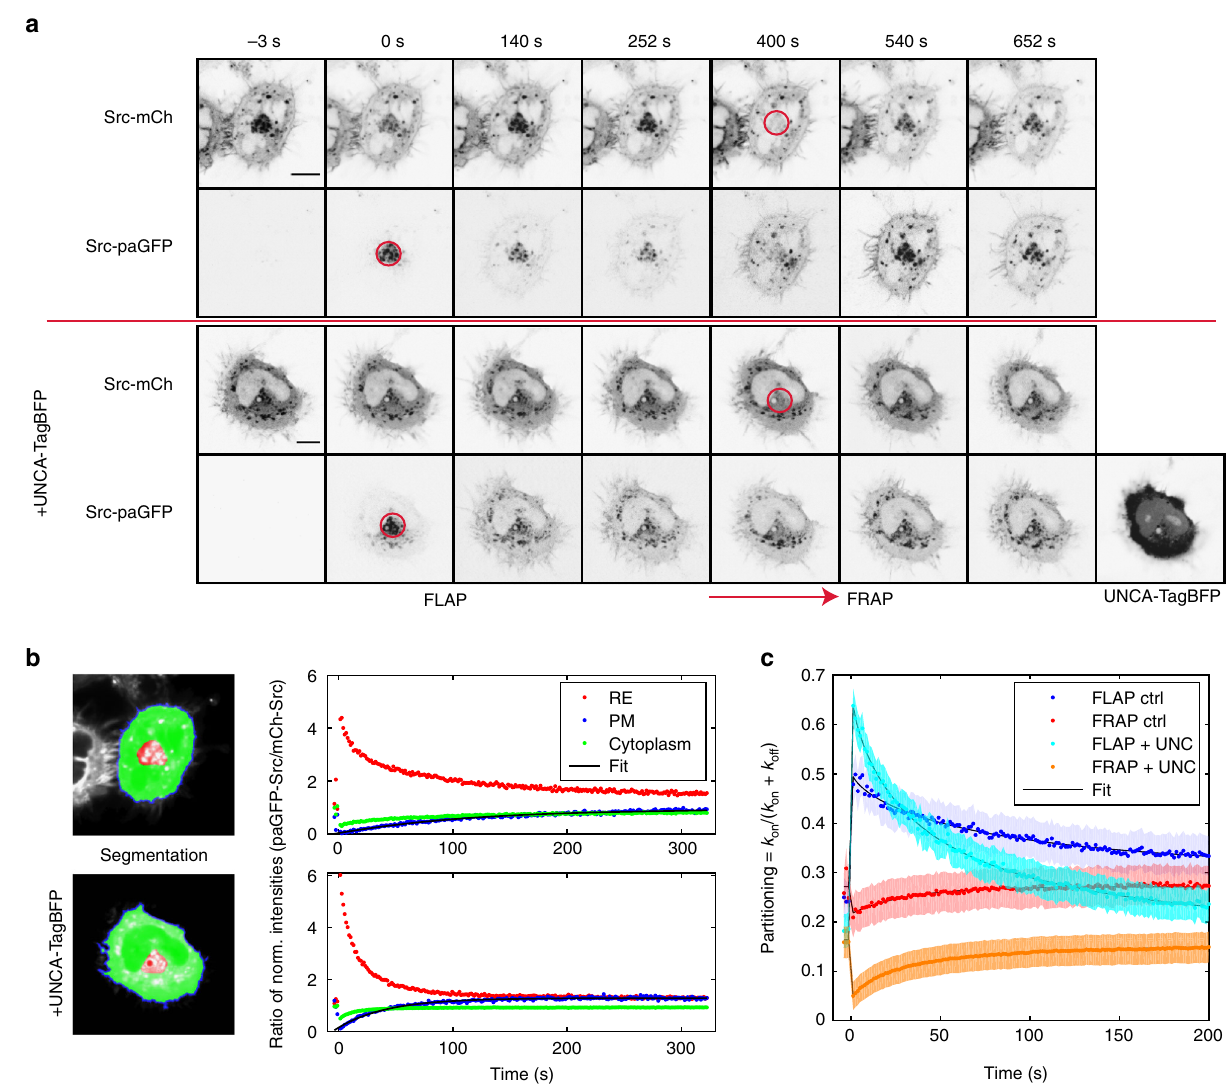
Fig. 6 Src released from UNC119 by Arl2/3 is trapped at the RE to be transported to the PM. a Representative time-lapse sequences of fl uorescence distribution of HeLa cells co-expressing Src-mCh ( fi rst and third rows ) and SrcWT-paGFP ( second and fourth rows ) in the absence ( fi rst and second rows ) or presence ( third and fourth rows ) of UNC119A-TagBFP ectopic expression. Src-paGFP was photoactivated at 0 s in the perinuclear region and subsequently Src-mCh was photobleached at 400 s in the same area (photoactivation/photobleach area: red outline ). b Segmentation of cells in ( a ): RE ( red ), PM ( blue outline ) and communicating cytoplasm ( green ). The ratio of Src-paGFP fl uorescence per segment (RE, red ; PM, blue ; cytoplasm, green ) over total fl uorescence in the cell and normalised to the respective ratio of Src-mCh fl uorescence was plotted against time. The PM ratio was fi tted to a mono-exponential recovery ( black line ). c Average traces of FLAP and FRAP curves fi tted to the compartmental model described in Methods. Loss of Src-paGFP fl uorescence at the perinuclear region normalised to whole-cell Src-paGFP fl uorescence ( blue and cyan curves ) and corresponding gain of Src-mCh fl uorescence after photobleaching at the same ROI, normalised to whole-cell Src-mCh fl uorescence ( red and orange curves ). Control cells: mean ± SEM; n = 5 cells ( blue and red curves ), UNC119 ectopic expression: mean ± SEM; n = 6 cells ( cyan and orange curves ). Scale bars , 10 μ